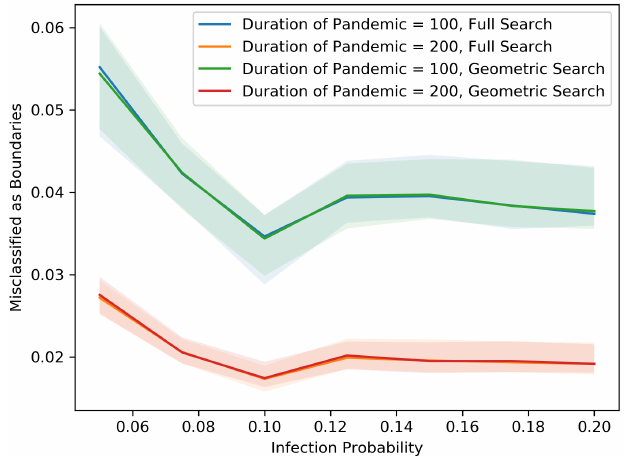
Figure 11. Misclassified As Boundaries. Population = 250,000 Non-cooperative Rate = 0.333. N: number of people inside and containing the external boundary.